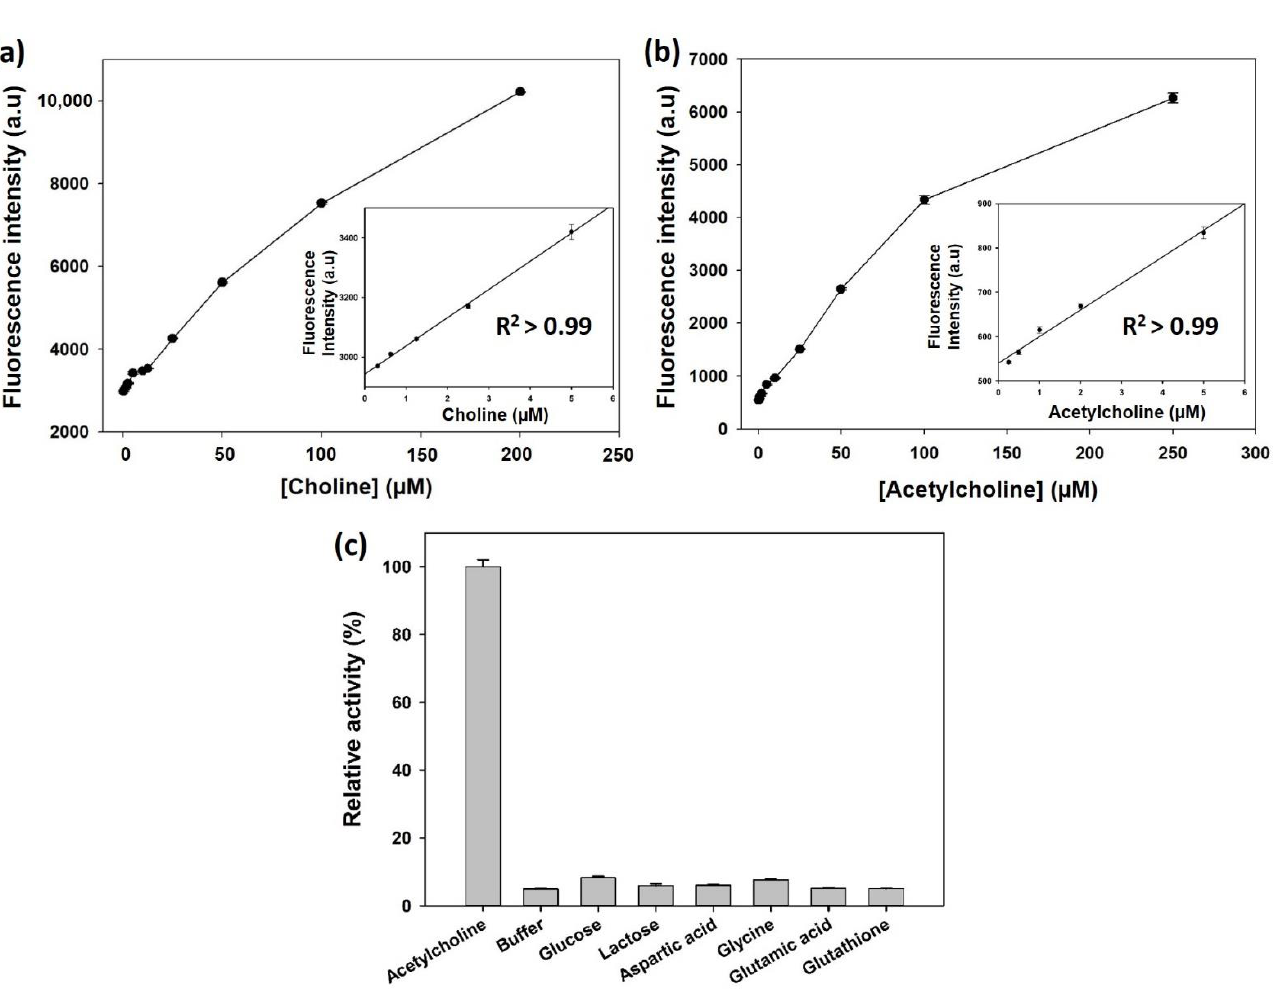
Figure 5. Dose-response curve for the detection of ( a ) choline and ( b ) ACh with their corresponding linear calibration plots using His@MNPs based assay. ( c ) Selectivity of His@MNPs based assay towards ACh. In the assay, concentration of ACh is 10 µM while other interfering substances are all 100 µM.